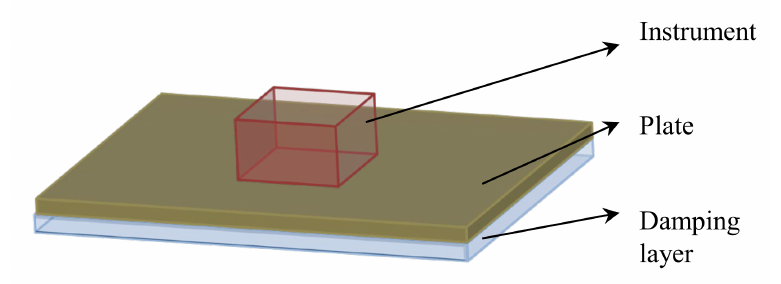
Figure 28. Composite plate with an instrument installed at the